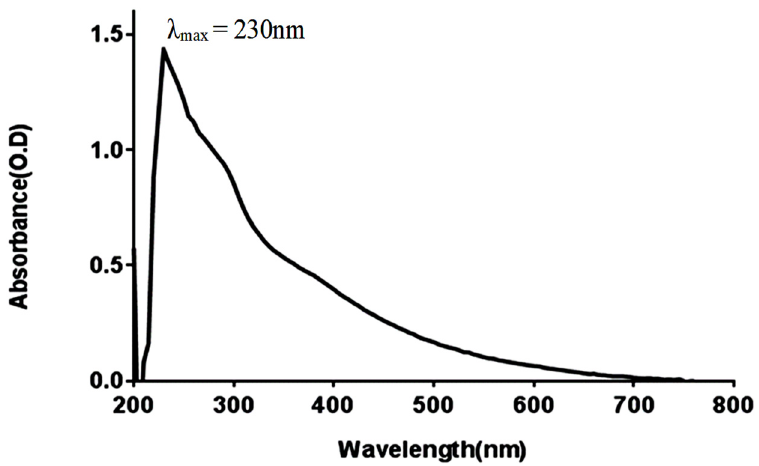
Figure 4. UV-visible absorbance spectrum of melanin produced by G. oxydans FBFS